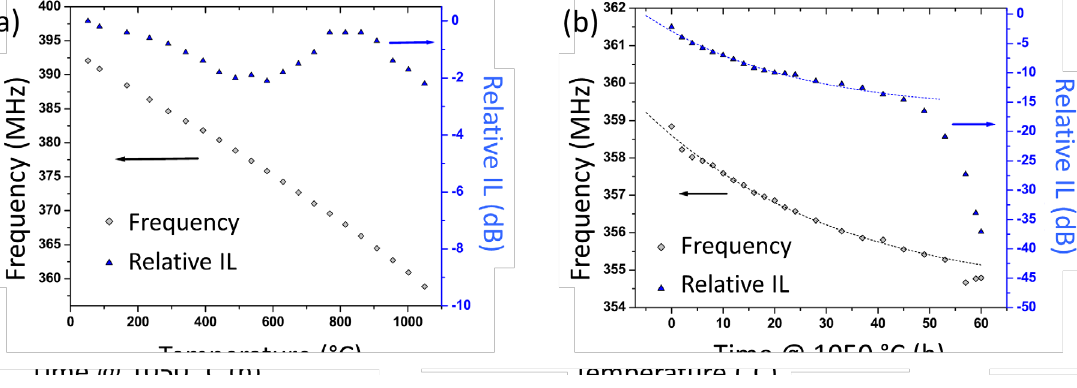
Figure 10. ( a ) The measured frequency shift and relative insertion loss as a function of temperature up to 1,000 °C. ( b ) The measured frequency shift and relative insertion loss as a function time at 1,050 °C [68] (copyright 2013 by the American Institute of